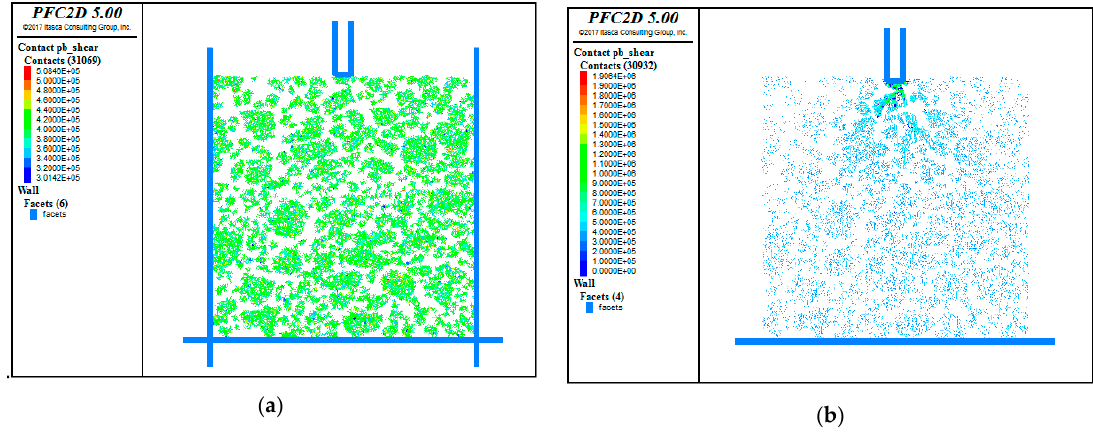
Figure 15. Comparison of shear stress before and after the test. ( a ) Before the test; ( b ) After the test